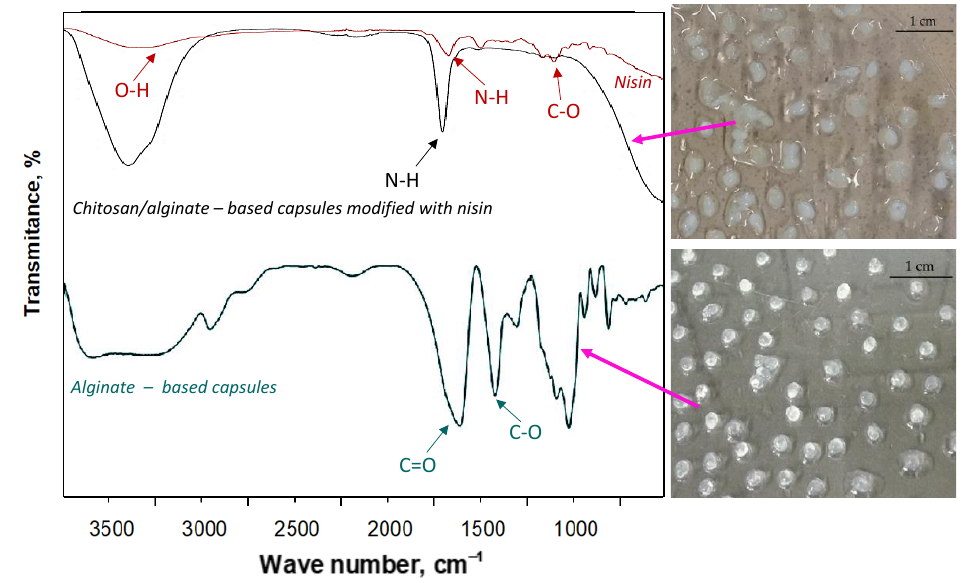
Figure 12. FT-IR spectra of nisin (red), chitosan/alginate-based capsules (black) and alginate-based capsules (blue) ( left ) and corresponding images of capsules ( right ).